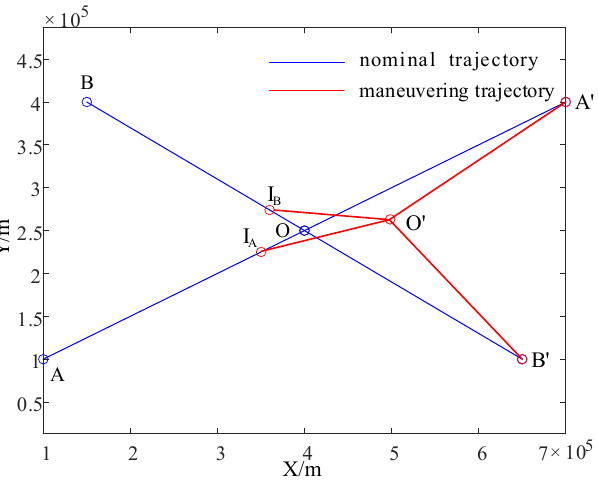
Figure 6. Trajectory diagram of minimum yaw separation assurance strategy.